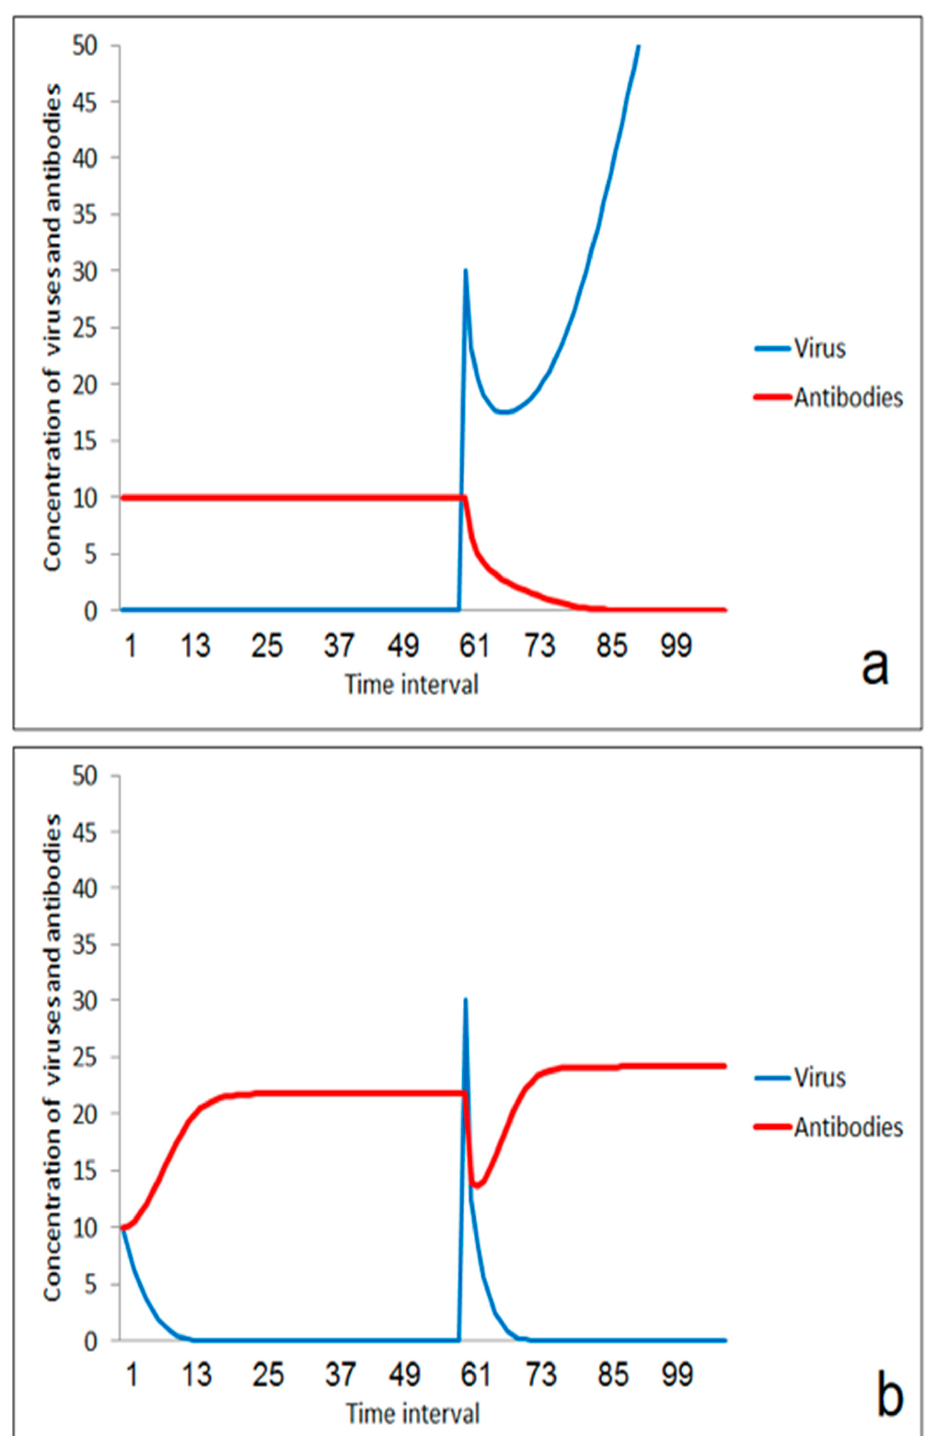
Figure 3. Effect of moderate first virus impact on the reaction on a second impact: ( a ) without immunization by the first impact, ( b ) after enhancement of immune-reaction after the first impact.